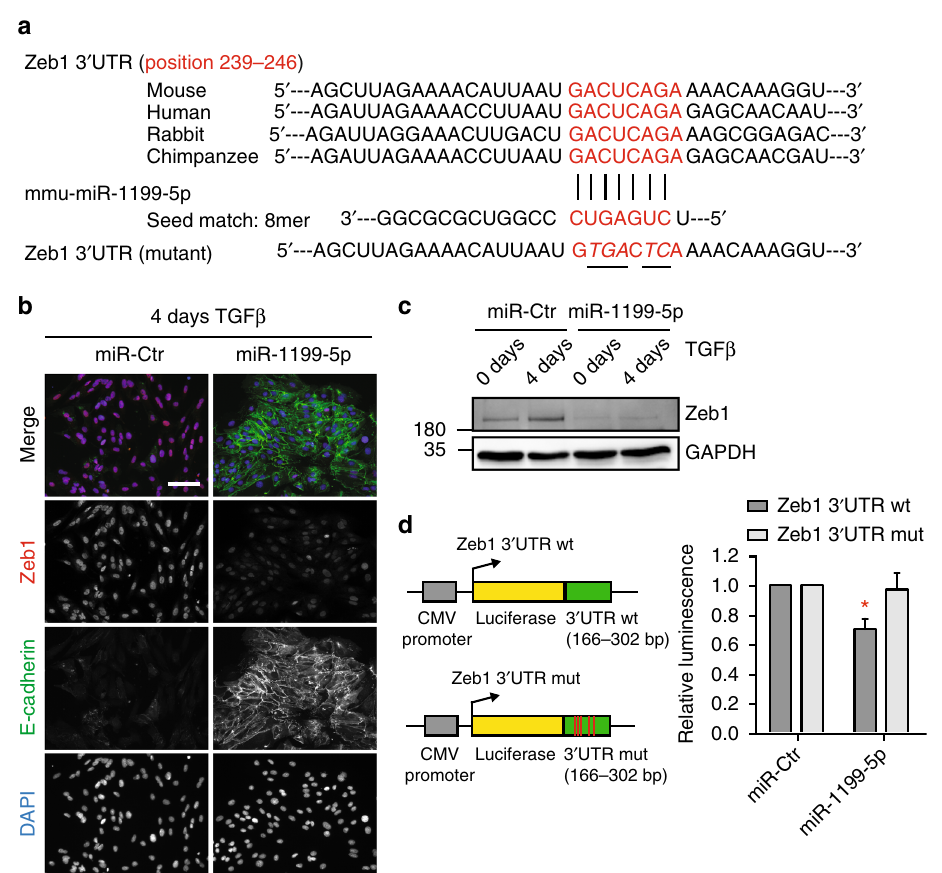
Fig. 4 miR-1199-5p directly controls Zeb1 expression. a Species-conserved miR-1199-5p-binding site in the 3 ′ UTR of Zeb1. The scheme represents: top: sequence alignments of predicted binding sites of miR-1199-5p (red; mouse: position 239 – 246) in Zeb1 3 ′ UTRs of different species. Middle: alignment of the 8mer seed match in mouse miR-1199-5p. Bottom: mutated miR-1199-5p seed sequence in the 3 ′ UTR of Zeb1 mRNA utilized for the control reporter construct (Zeb1 3 ′ UTR mut) in d . Exchanged nucleotides are underlined. b , c Forced expression of miR-1199-5p reduces Zeb1 nuclear localization and protein levels during an EMT. NMuMG/E9 cells were transiently transfected with miRNA mimics as indicated and cultured in the absence (0 day) or presence of TGF β (4 days). Immuno fl uorescence ( b ) and immunoblotting ( c ) analyses illustrate the differences in Zeb1 protein levels. Scale bar: 100 μ m. d Post-transcriptional regulation of Zeb1 by miR-1199-5p. NMuMG/E9 cells were transfected with the miRNA mimics indicated, with a Renilla luciferase reporter construct and with either a Zeb1 3 ′ UTR wild-type (wt) or a Zeb1 3 ′ UTR mutant (mut) Fire fl y luciferase reporter construct. Relative luminescence (Fire fl y/Renilla) was calculated and normalized to miR-Ctr-transfected cells (mean fold changes ± s.e.m.; n = 3; signi fi cance determined by an unpaired, two-sided t test; * P <